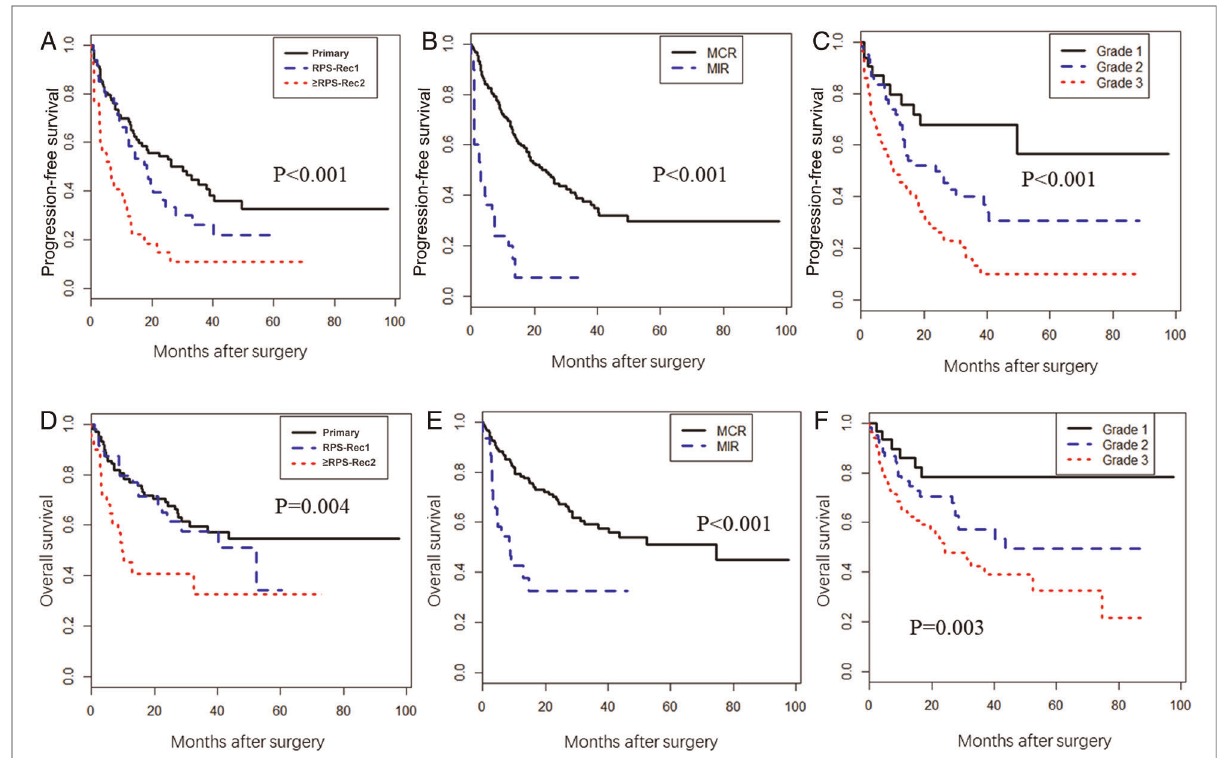
FIGURE 4 Progression-free survival (PFS) and overall survival (OS). ( A ) The PFS in primary, RPS-Rec1, and ≥ RPS-Rec2 patients (primary vs. RPS-Rec1, P =0.151; primary vs. ≥ RPS-Rec2, P <0.001). ( B ) The PFS in MCR and MIR patients ( P <0.001). ( C ) The PFS in different grade RPS patients (grade 1 vs. grade 2, P =0.042; grade 1 vs. grade 3, P <0.001). ( D ) The OS in primary, RPS-Rec1, and ≥ RPS-Rec2 patients (primary vs. RPS-Rec1, P =0.599; primary vs. ≥ RPS-Rec2, P =0.001). ( E ) The OS in MCR and MIR patients ( P <0.001). ( F ) The OS in different grade RPS patients (grade 1 vs. grade 2, P =0.069; grade 1 vs. grade 3, P =0.002). MCR, macroscopically complete resection; MIR, macroscopically incomplete